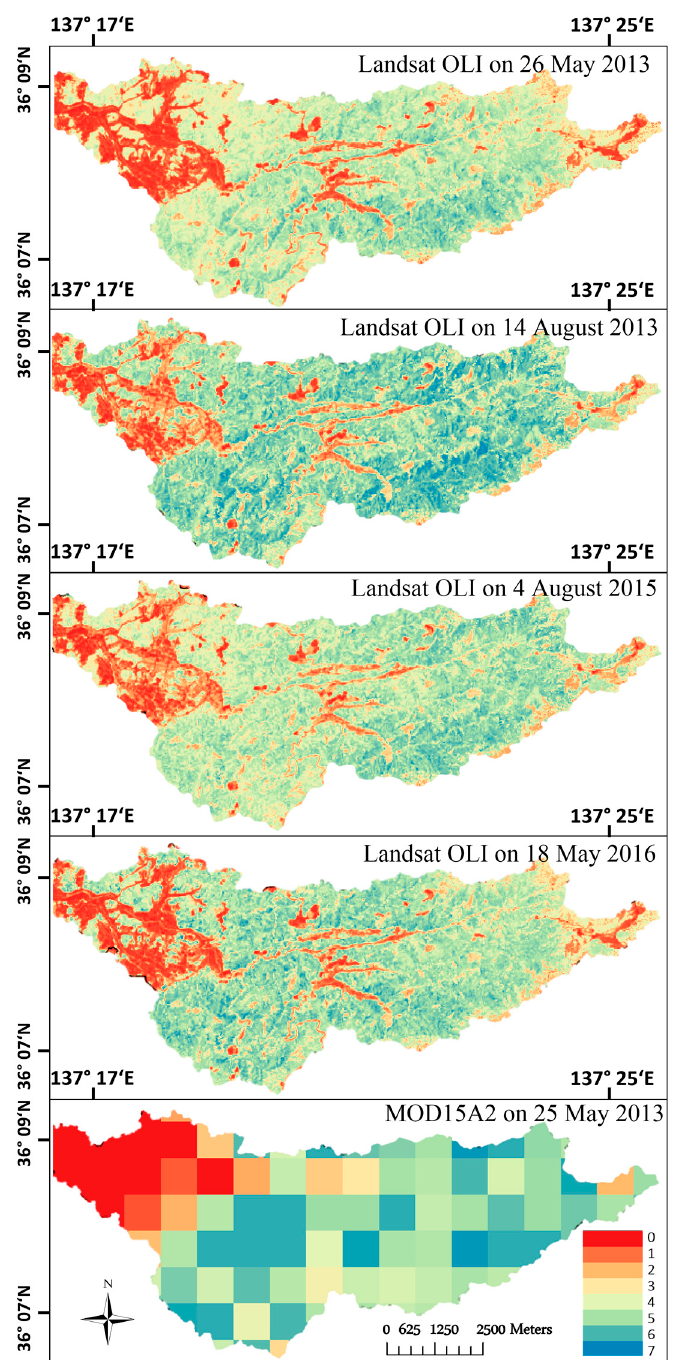
Figure 6. LAI estimations based on Landsat OLI sub-images dated 26 May 2013, 14 August 2013, 4 August 2015, and 18 May 2016, and the LAI map from the MOD15A2 dated 25 May 2013 over the Daihachiga river basin. The red color (LAI = 0) outlines the urban areas, grasslands, water objects, rice paddies, crops, and bare lands.